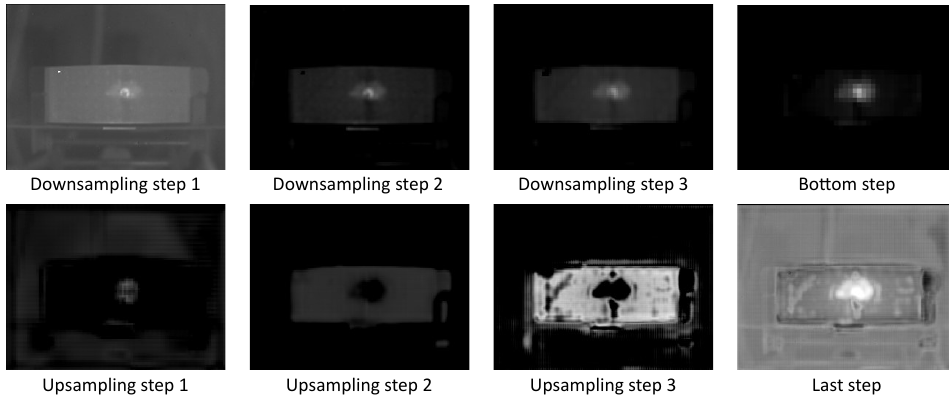
Figure 10. Layer activation maps of a trained deep model for LWIR